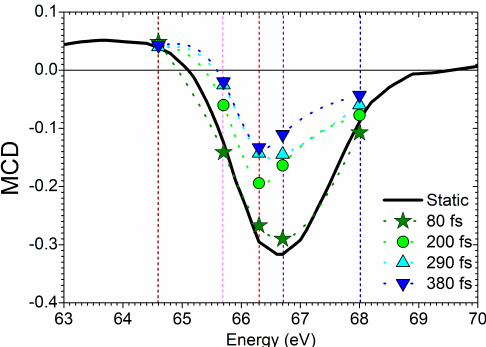
Figure 5. Calculated static MCD spectra (black line) and measured MCD spectra for different time delays (colored